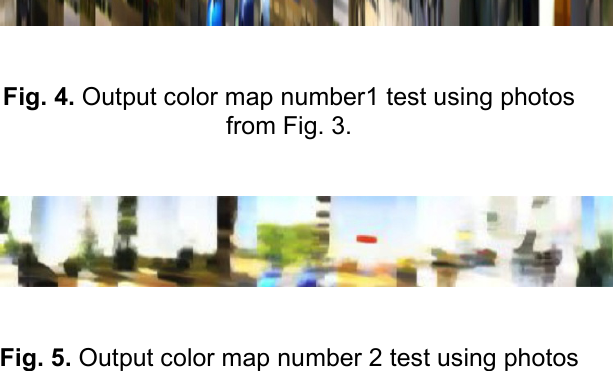
Fig. 5. Output color map number 2 test using photos from Fig. 3.